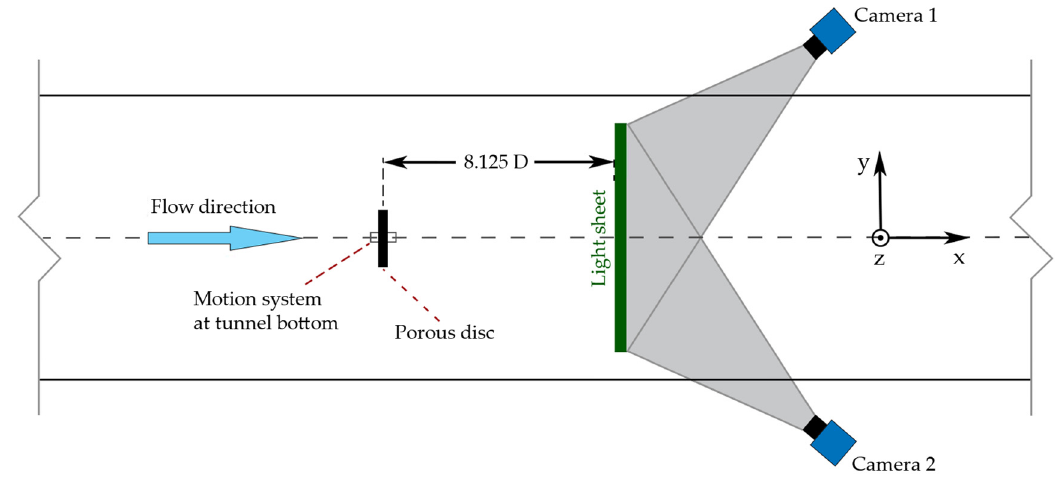
Figure 3. Arrangement of the turbine model and S-PIV measurement system.